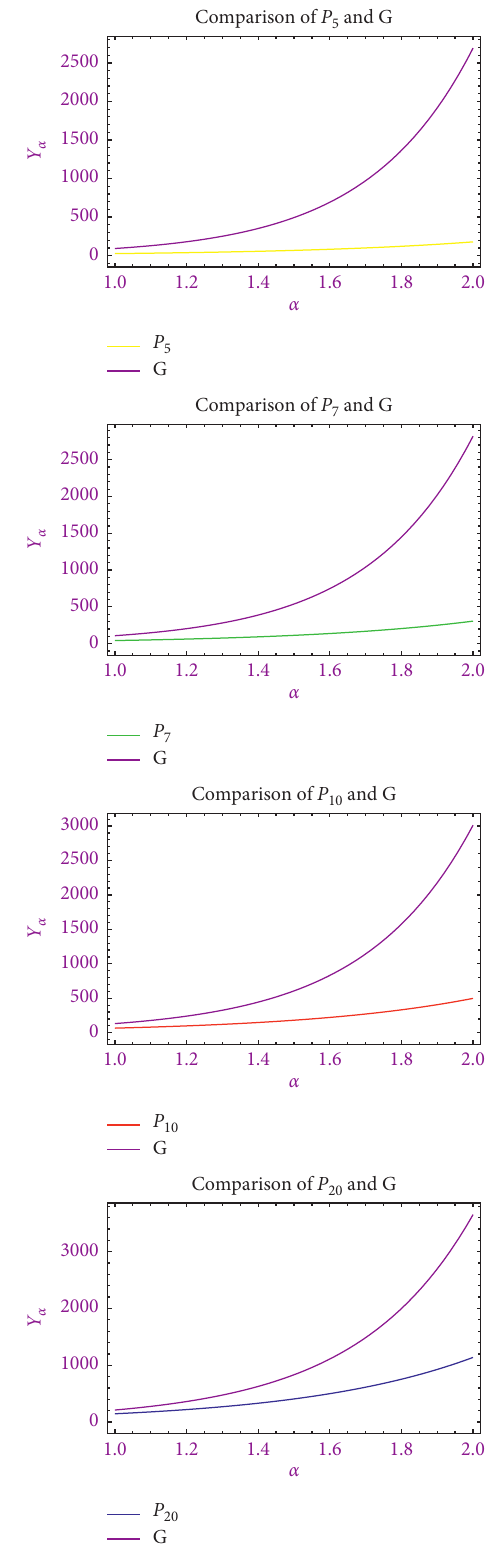
Figure 6: Plot for Y